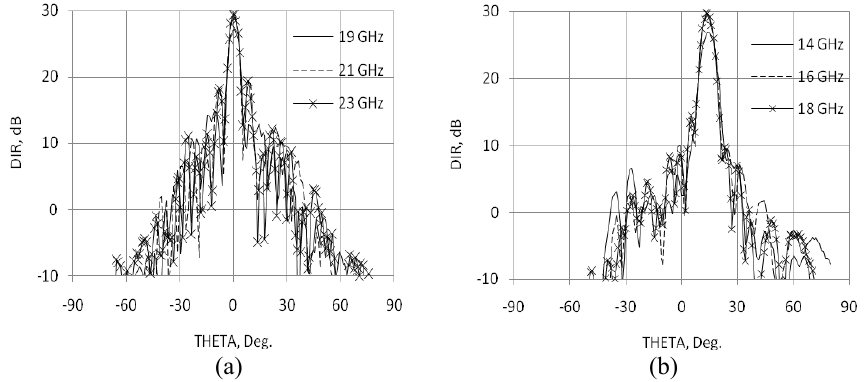
Fig. 8. Experimental radiation patterns: (a) of the single-layer antenna; (b) of the two-layer antenna. Experimental radiation patterns in the yz plane are presented in Fig. 8 (a) for the single- layer antenna and Fig. 8 (b) for the two-layer antenna in corresponing frequency